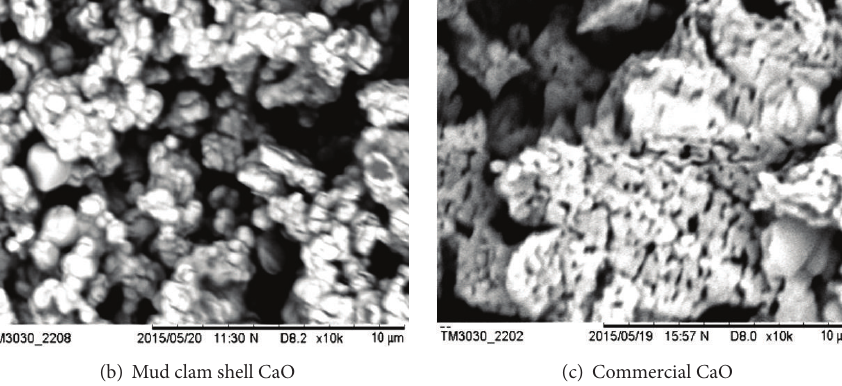
Figure 2: SEM images of heterogeneous catalyst and its raw material.